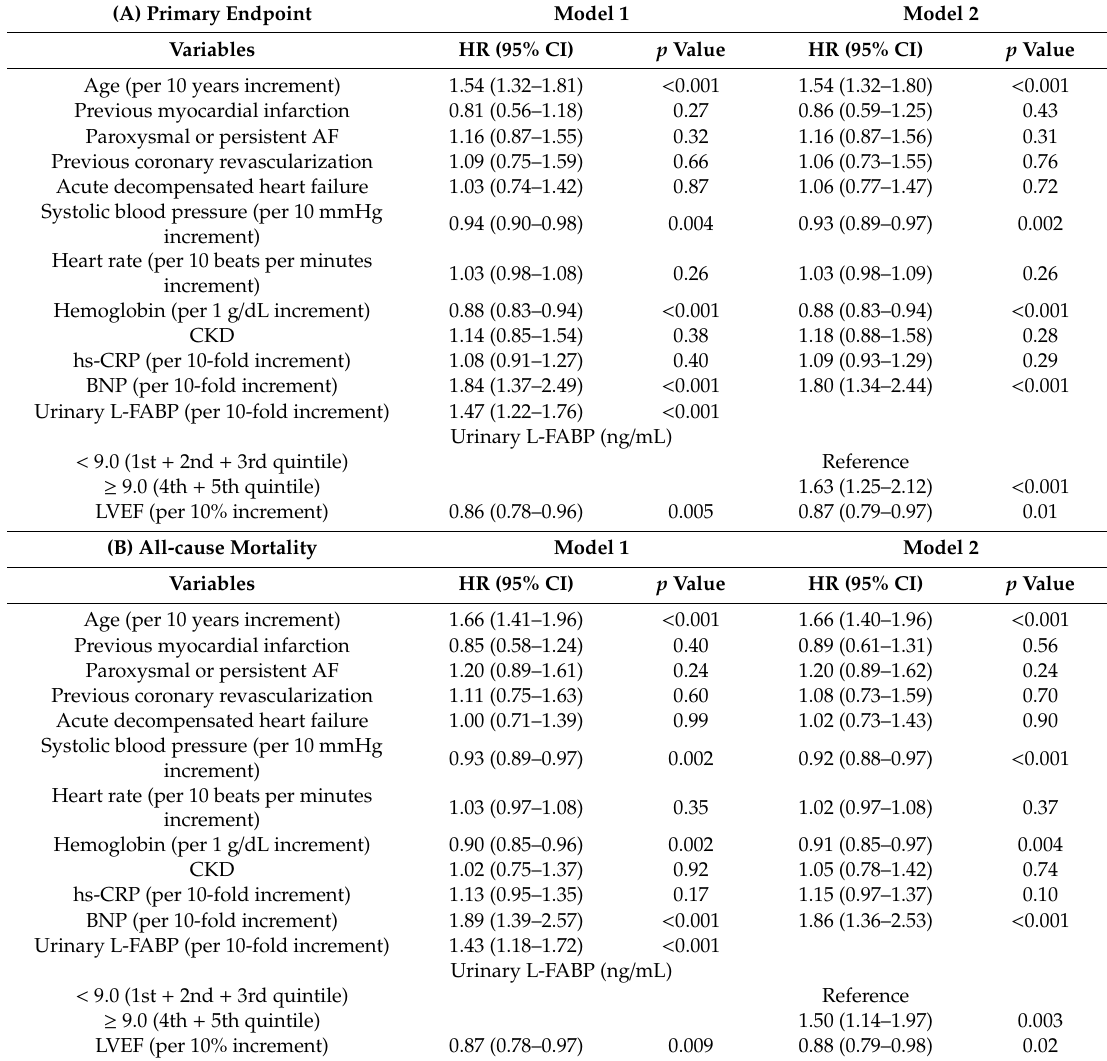
Table 3. Multivariate predictors of primary endpoint and all-cause